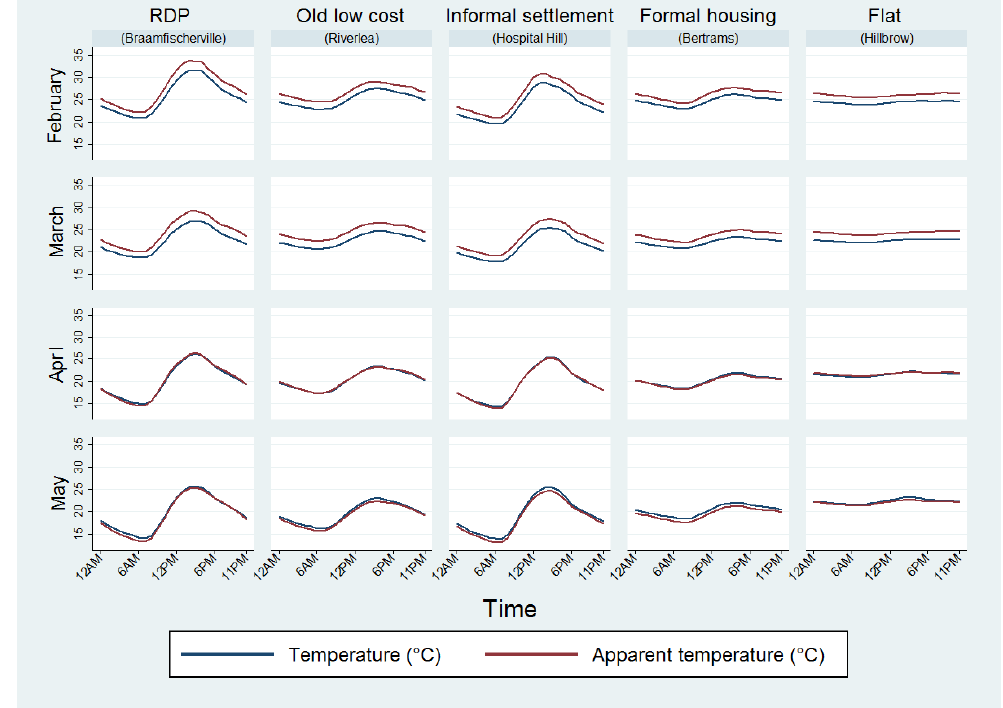
Figure 4. Mean measured and apparent temperatures experienced throughout the day.